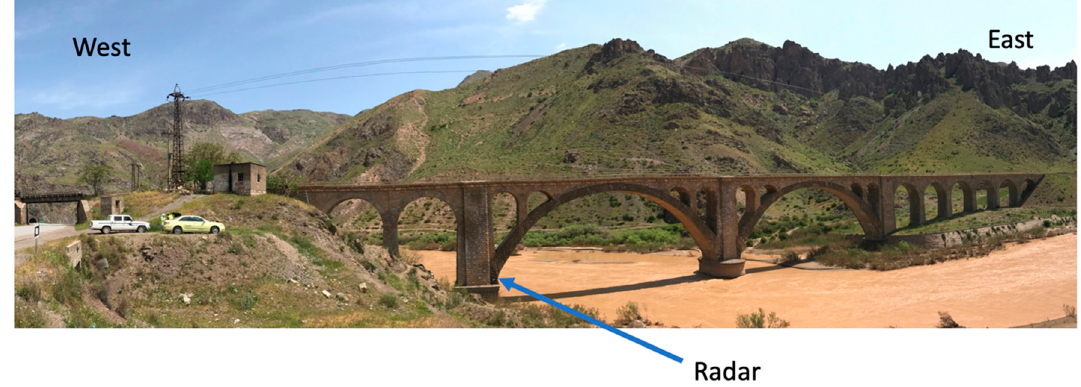
Figure 2. Kaflan-Kuh Bridge, Northern Iran.